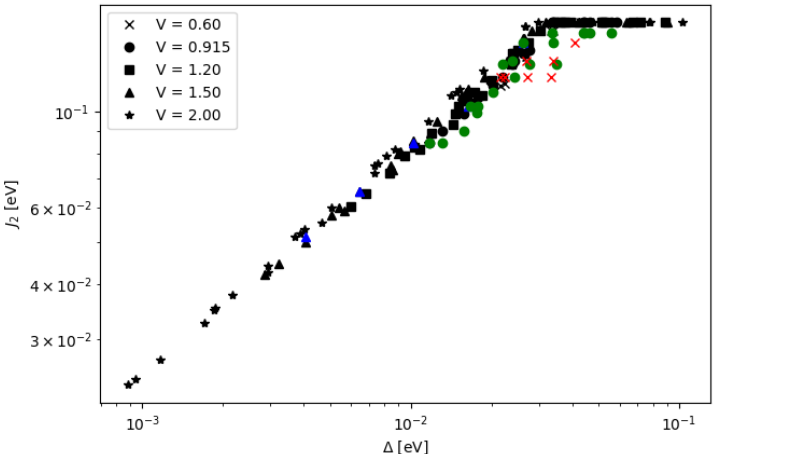
Figure 14. The inter-qubit coupling energy J 2 and the energy gap ∆ which give the maximum ∆ P of the DQDs are plotted in the log-log scale. Calculations from the matrix model are in black and those from the electronic potential model are in other